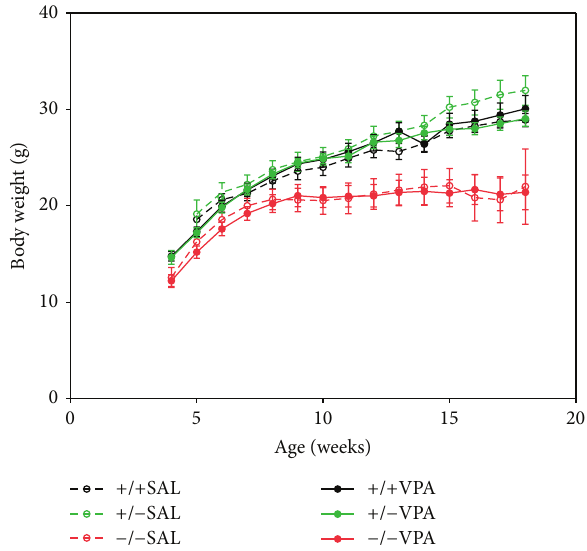
Figure 1: Body weight of male WT and Wfs1 mutant mice. At the age of 16 months, Wfs1 KO (red circles) had lower body weight than WT (black circles) or heterozygous HZ (green circles) mice ( 𝐹(2,35) = 7.97 ; 𝑃 = 0.0014 ). Growth rate of Wfs1 KO mice was inhibited since 8th to 9th week of age, while the body weight of WT and HZ continued to increase ( 𝐹(24,420) = 9.65 ; 𝑃 < 0.000001 ). Chronic administration of VPA for 3 months (300mg/kg/day, i.p. solid symbols) had no effect on growth rate regardless of genotype ( 𝐹(1,35) = 1.43 ; 𝑃 = 0.2393 ). Data is presented as mean ± SEM ( 𝑛 = 8